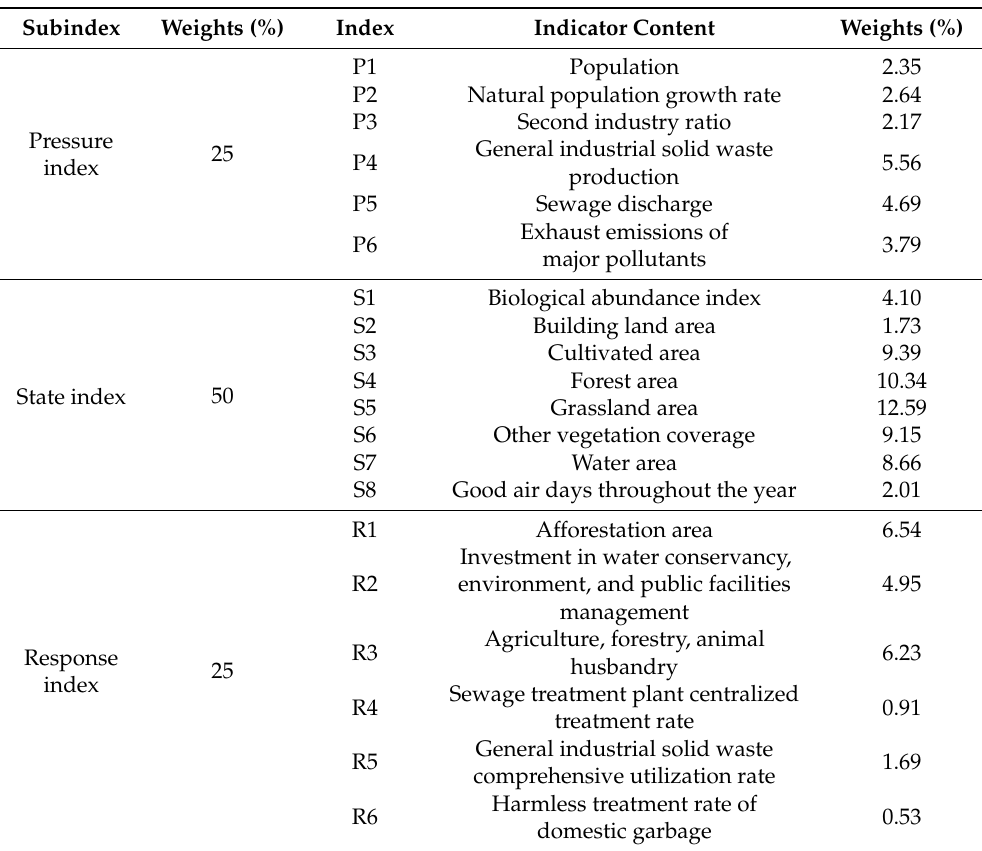
Table 3. Weights of UGEI